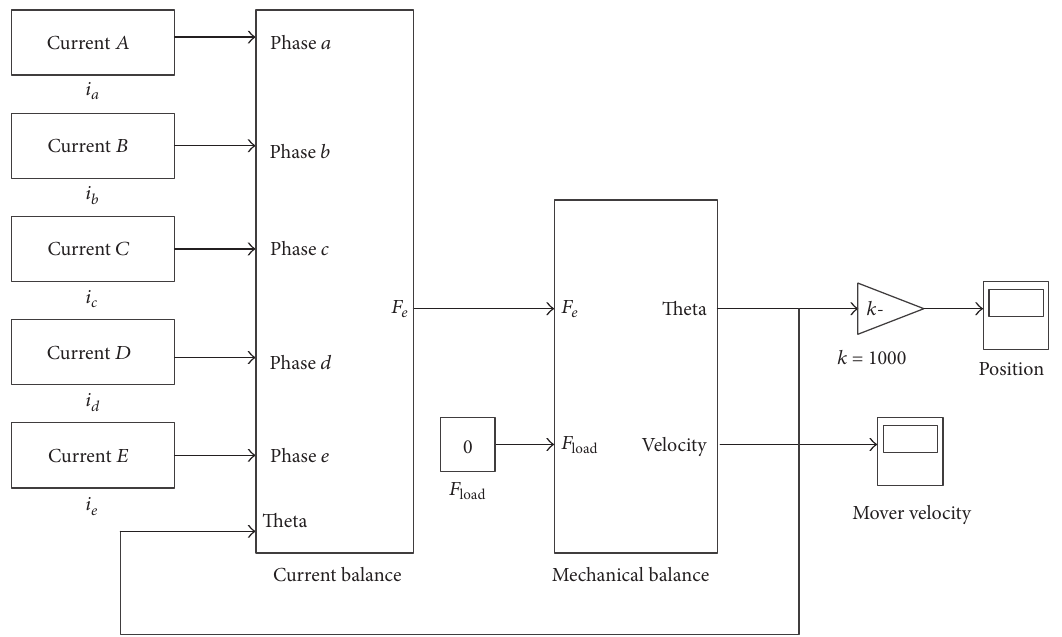
Figure 7: Establishment of the studied motor model on Matlab/Simulink